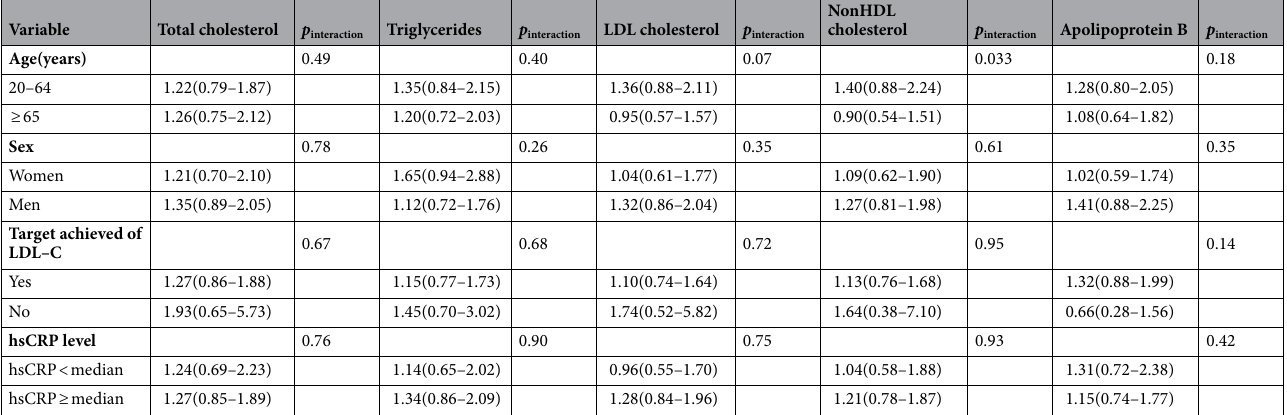
Table 3. Subgroup analyses for the associations of the levels of the lipoproteins (higher risk group vs. lower risk group) with incident cardiovascular disease according to age, sex, target achievement status of low-density lipoprotein and different levels of hsCRP. LDL-C low density lipoprotein